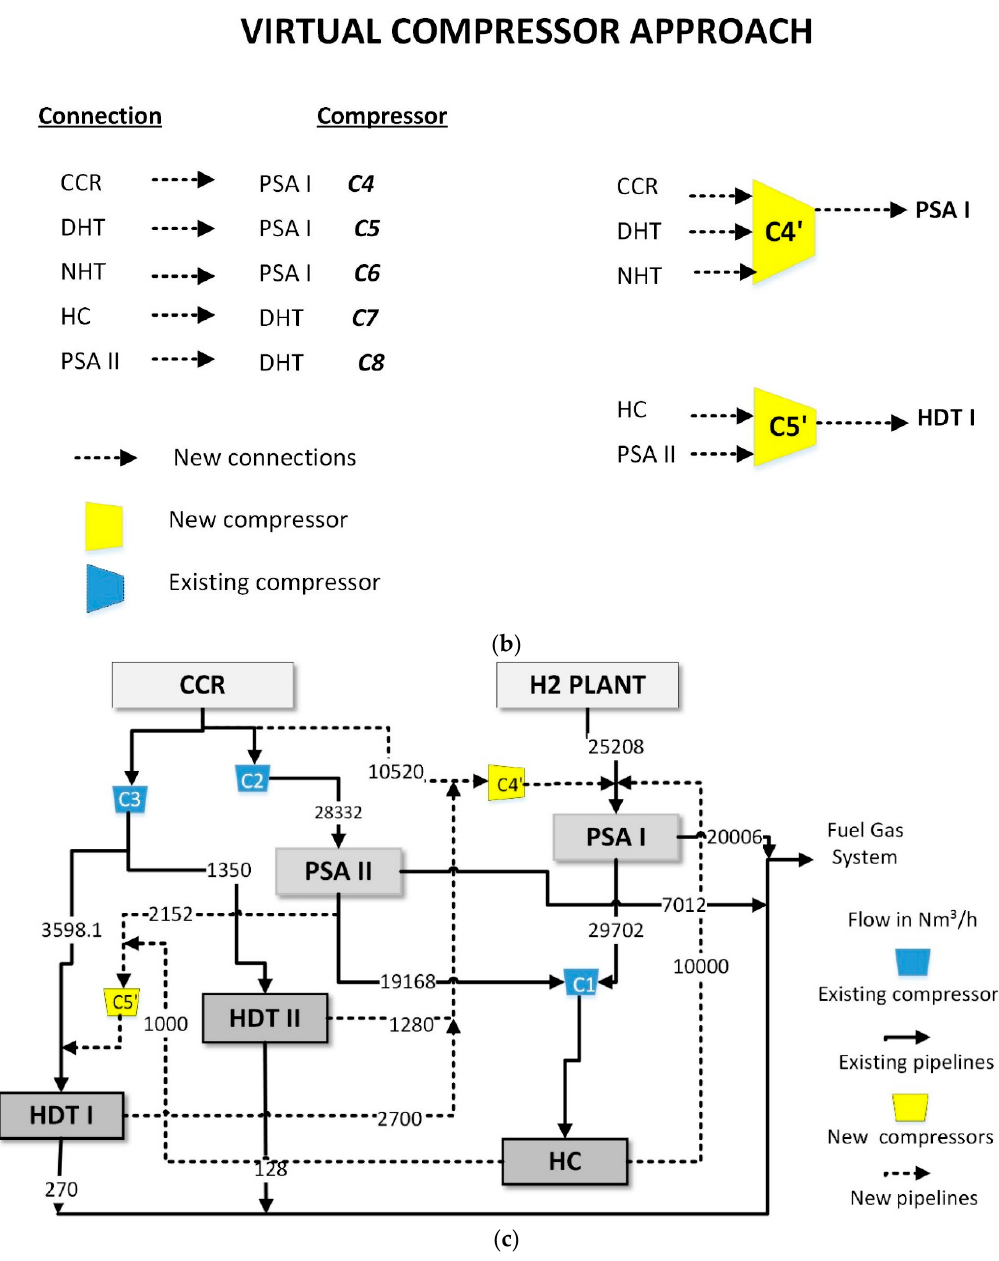
Figure 8. ( a ) Optimized network HN5 via HNS LM for Example 2. ( b ) Virtual compressors applied to HN5 network. ( c ) Optimized network HN5’ with rearranged compressors.